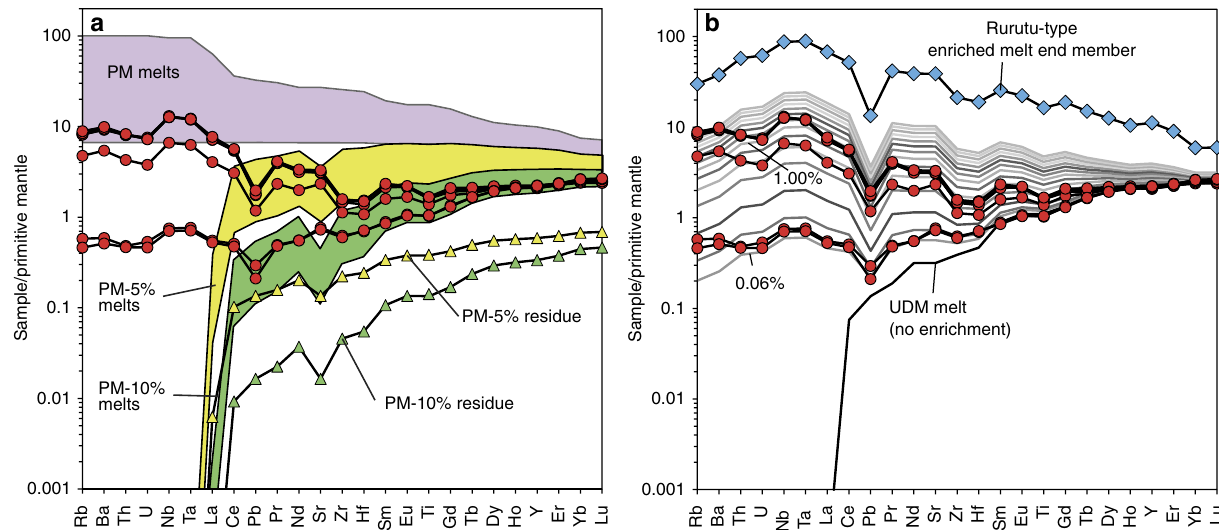
Figure 4 | Two-stage mantle melting and source mixing to generate low-Ti primary Manihiki magmas. ( a ) Primitive-mantle-normalized multi-element plot of incompatible elements showing the compositions of primary low-Ti melts calculated from the compositions of Manihiki glasses (Supplementary Table 3; red circles); the ranges of melt compositions produced by pooled (aggregate) fractional melting from 1% to 15% of primitive mantle (PM) and of residual primitive mantle after 5% (PM-5%) and 10% (PM-10%) fractional melting; and residual mantle compositions after 5% and 10% previous melt extraction (yellow and green triangles, respectively). ( b ) The compositions of second stage melts produced by 8.7% pooled fractional melting of an UDM source. The UDM source was previously generated by 10.6% melt extraction from PM and subsequent enrichment/metasomatism with variable amounts (indicated in wt%) of melt corresponding in composition to the mafic Rurutu sample #RRT-B-30 from ref. 34. Details of the melt modelling are given in the discussion and input parameters in Supplementary Table